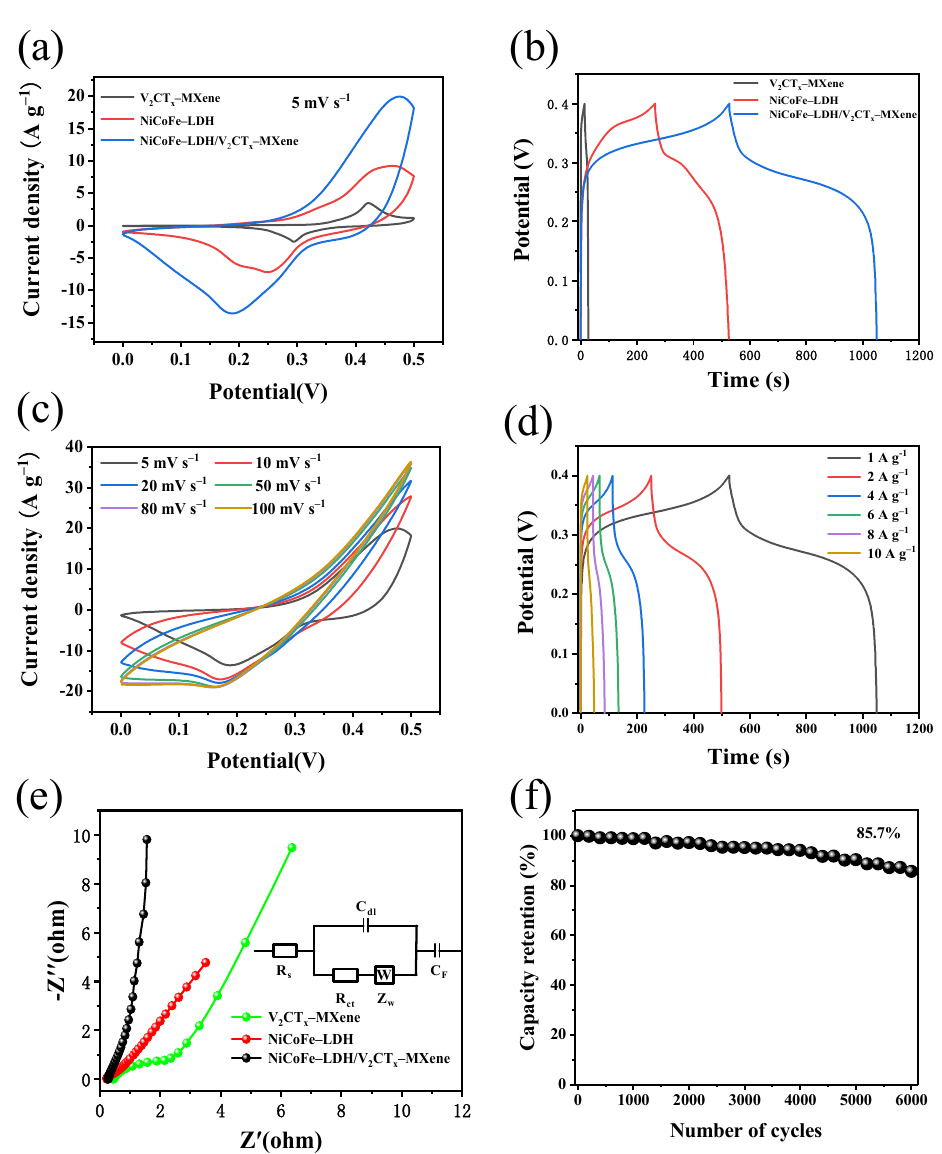
Figure 7. Comparison of the electrochemical performance of V 2 CT x –MXene, NiCoFe–LDH, and NiCoFe–LDH/V 2 CT x –MXene electrodes: ( a ) CV curve at 5 mV s − 1 ; ( b ) GCD curve at 1 A g − 1 ; NiCoFe–LDH/V 2 CT x –MXene; ( c ) CV curve; ( d ) GCD curve; ( e ) Nyquist plot (the inserted is the equivalent circuit); and ( f ) cycling stability at 10 A g − 1 .